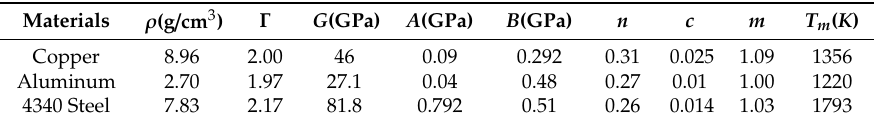
Table 3. Parameters of metal